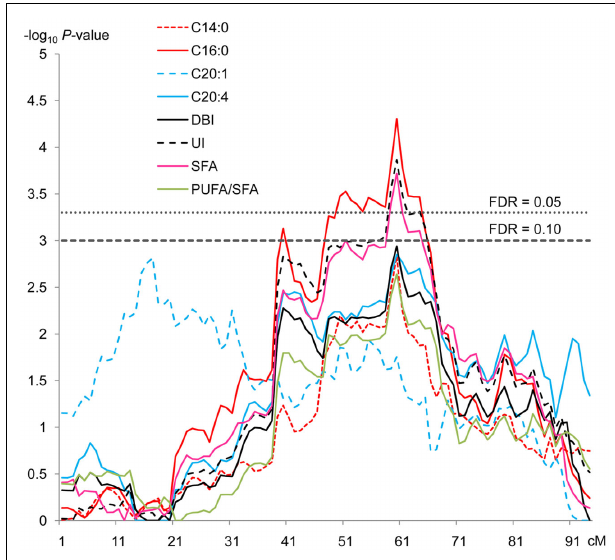
FIGURE 1 | QTL significant profiles for different fatty acids and indexes across SSC12. QTL regions affecting C14:0, C16:0, C20:1, and C20:4 fatty acids and DBI, UI, SFA and PUFA/SFA indexes. For each test, on the y -axis are − log 10 of P -values using a model of one QTL and on the x -axis, the position in cM. One of the cut off values is 3 representing a FDR = 0.10 and the other is 3.30 corresponding to a FDR = 0.05.